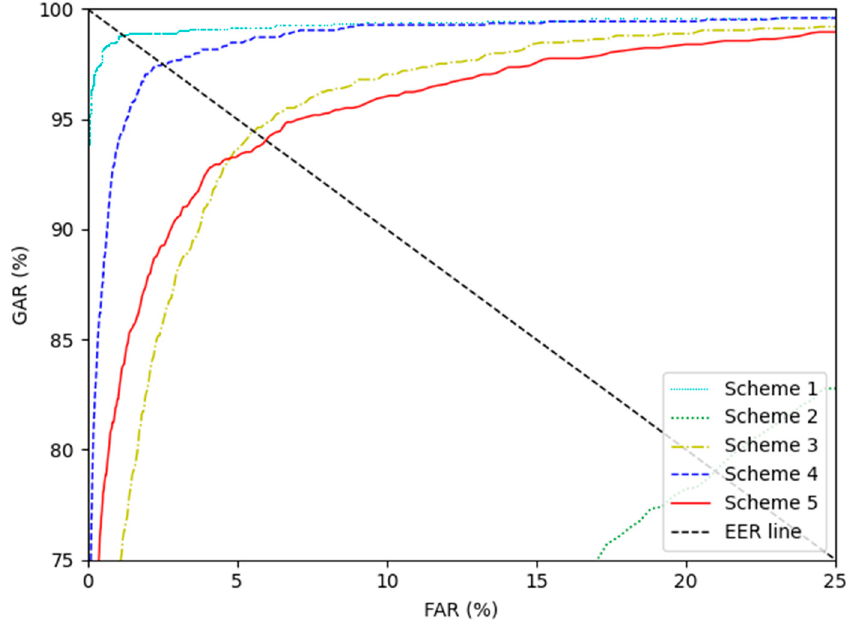
Figure 28. ROC curves of finger-vein recognition for schemes 1–5 with PolyU-DB (random motion blur and optical blur with intensity 15 × 15 (Gaussian filter size) and 15 (Gaussian filter standard deviation)).